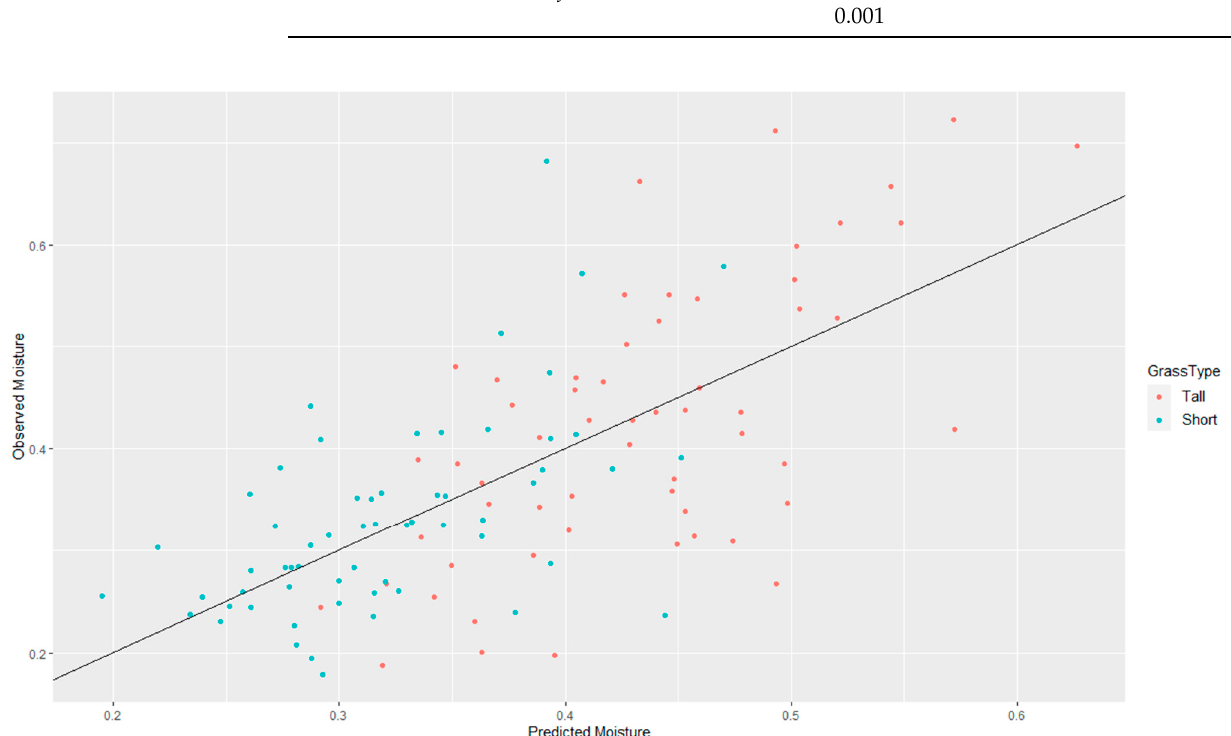
Figure 7. Fit for PCA + Total Weight Model by Grass Type. Equation (2): Equation of Best